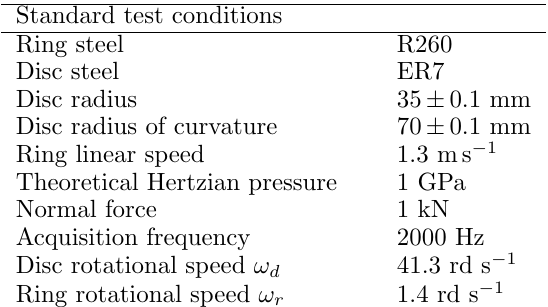
Table 1. Summary of common adhesion test